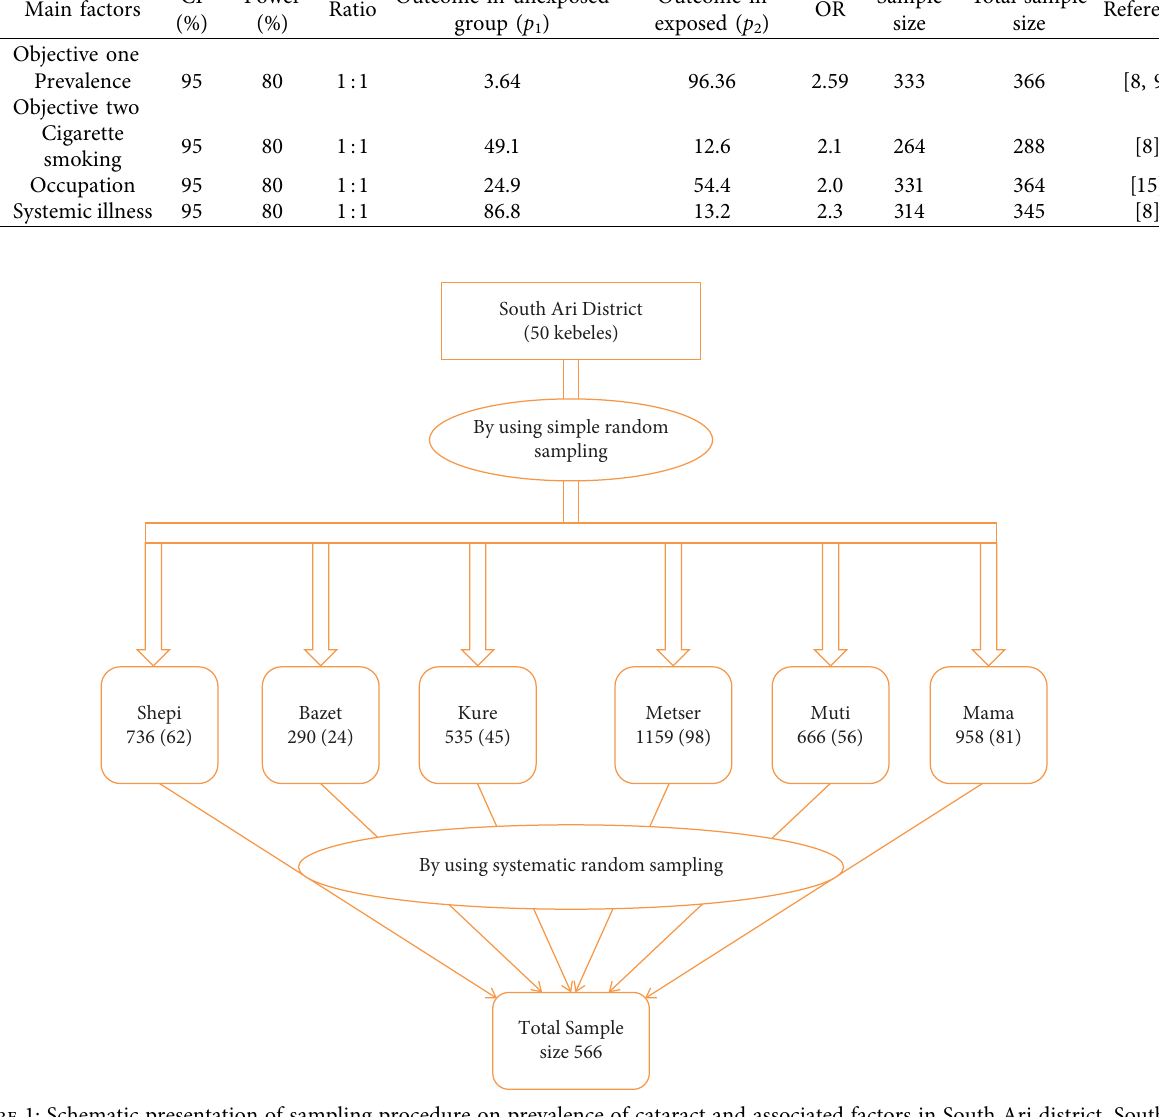
Figure 1: Schematic presentation of sampling procedure on prevalence of cataract and associated factors in South Ari district, Southern Ethiopia, in December